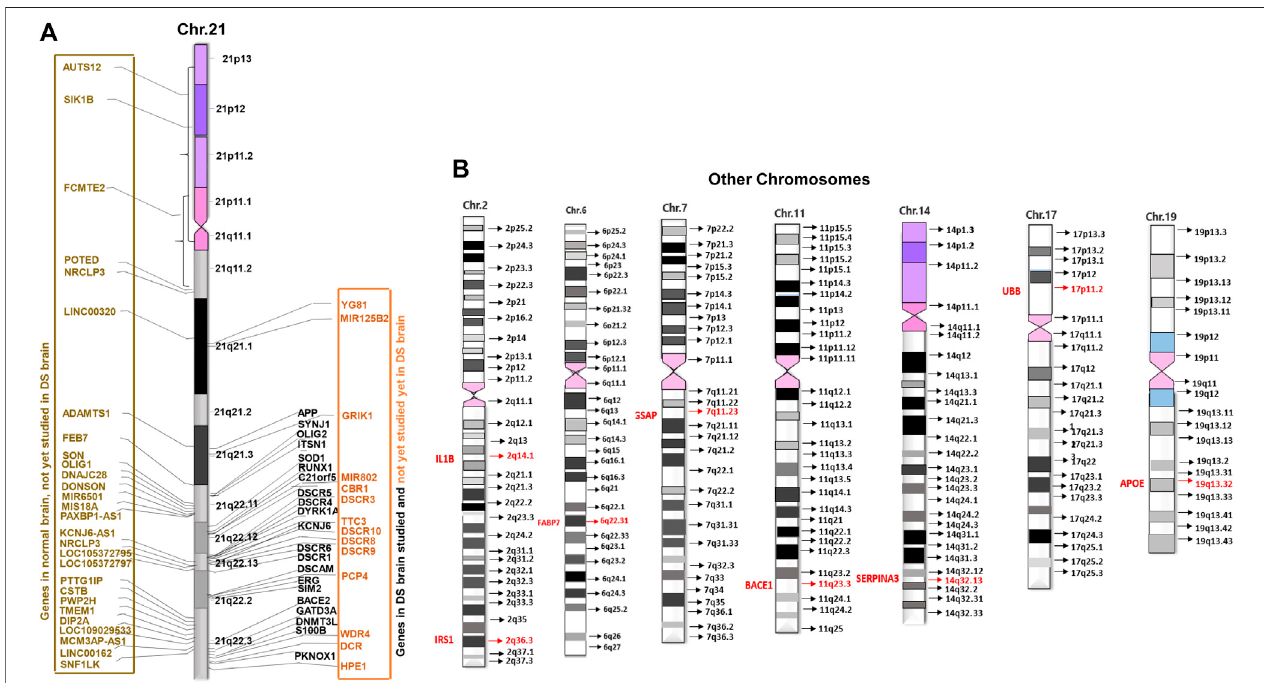
FIGURE3| Distributionofbraindevelopmentgenesinhumanchromosomes. (A) StudiedandnotyetstudiedbraindevelopmentgenesinnormalandbrainwithDS in Chromosome 21 (Chr21). (B) Studied brain development genes in other chromosomes in the brain with